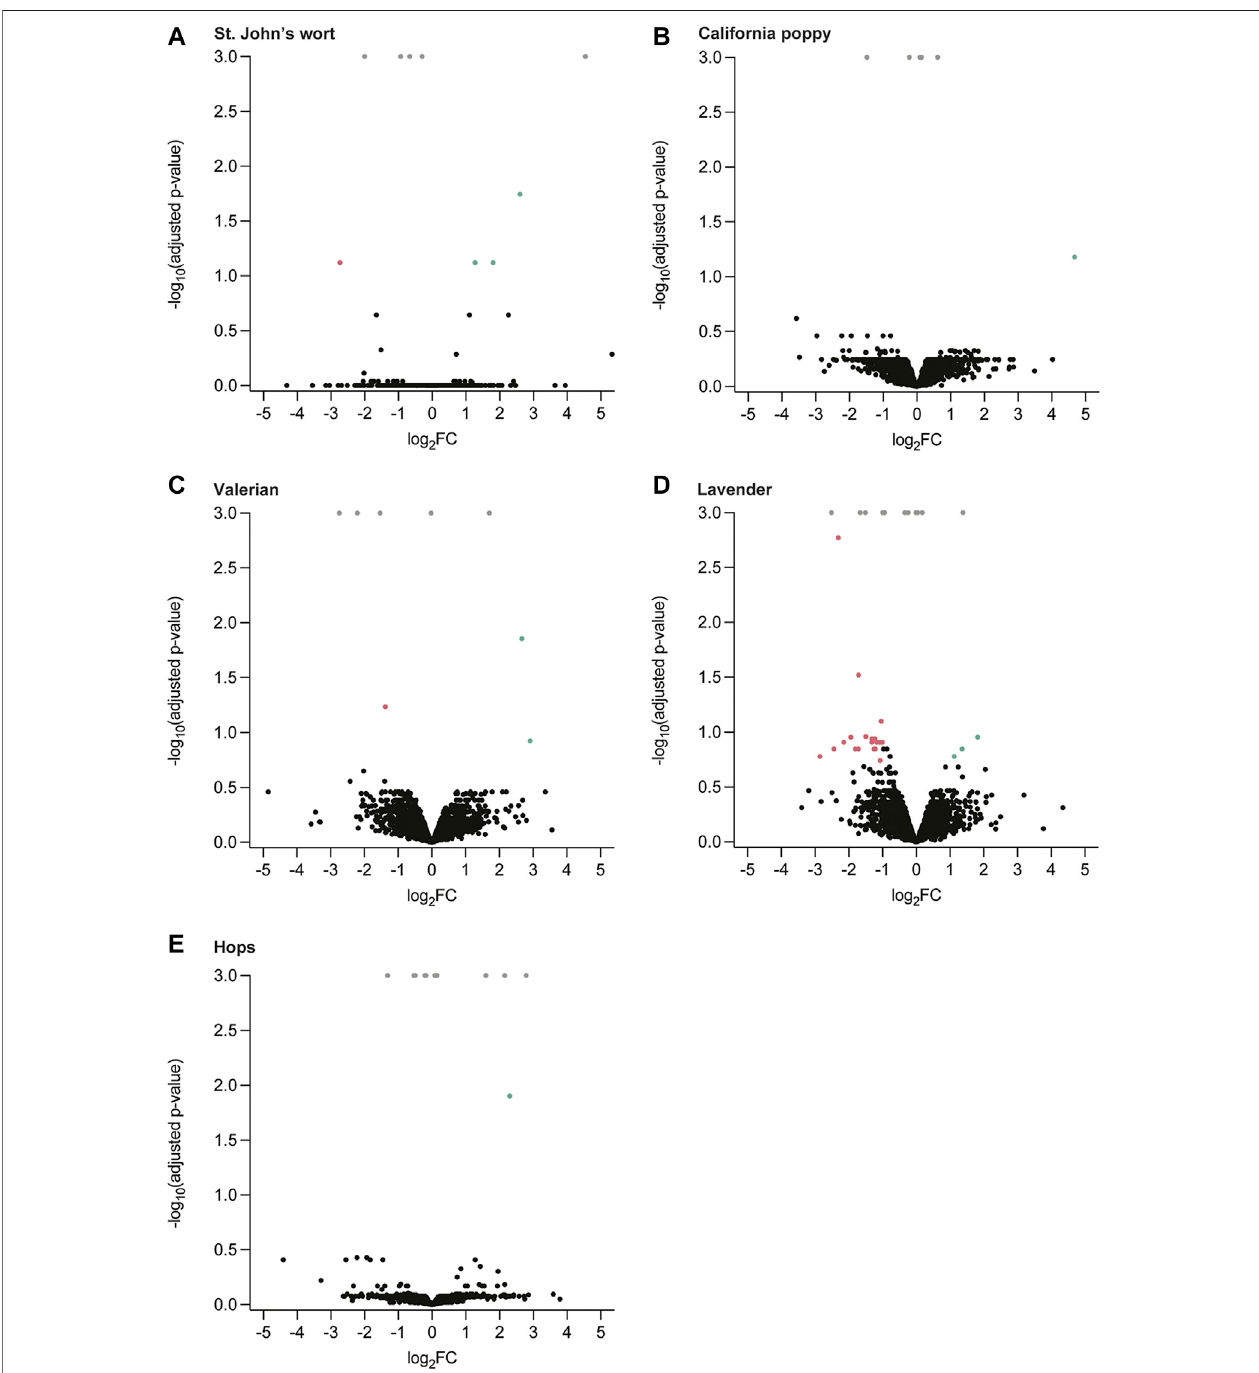
FIGURE 1 | Label-free quanti fi cation of proteinsof treated (herbal extracts) and untreated (0.06% DMSO) BeWo b30 cells for a period of48 h. Volcano plots representing identi fi edproteinsaslog 2 foldchange(FC)ratioofproteinintensity(treated/untreated),plottedagainstthesigni fi canceasafunctionofnegativelog 10 (adjusted p -value).Signi fi cantly (cid:129) (cid:129) enriched proteins (adjusted p -value ≤ 0.02) are colored accordingly ( log 2 FC > 1, log 2 FC > − 1). Insigni fi cantly different proteins are marked in black. Proteins that were only identi fi edineitherthetreatedoruntreatedsamplearedisplayedingray(adjusted p -value=0.001). (A) St.John ’ swort, (B) Californiapoppy, (C) valerian, (D) lavender,and (E) hops.